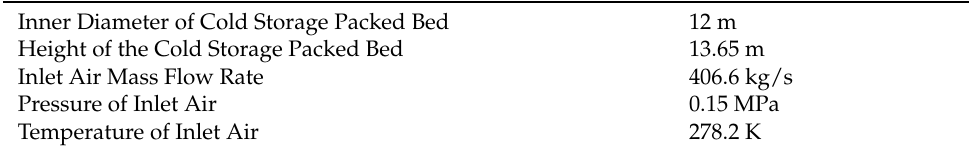
Figure 5. Model validation of the cold storage packed bed. Table 1. Operation conditions of the CSPB in model validation.